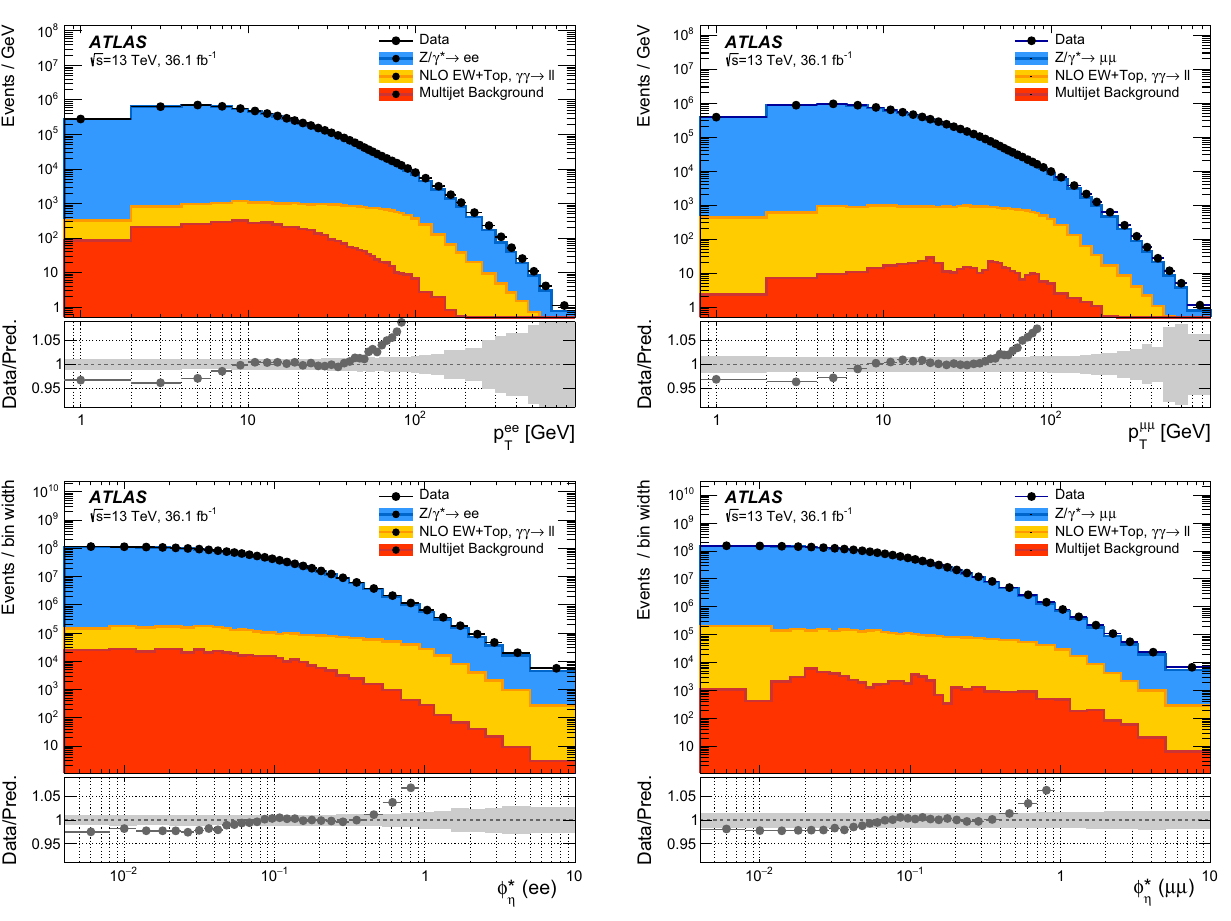
uncertainties of the data points are generally smaller than the size of the markers. The predictions are normalized to the integral of the data and the total experimental uncertainty of the predicted values is shown as a grey band in the ratio of the prediction to